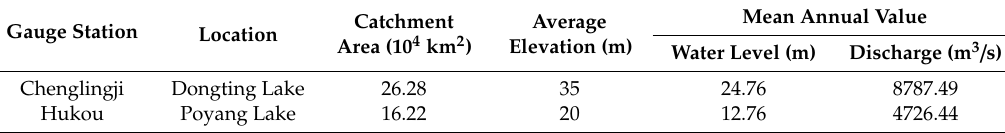
Table 1. List of gauge stations and their